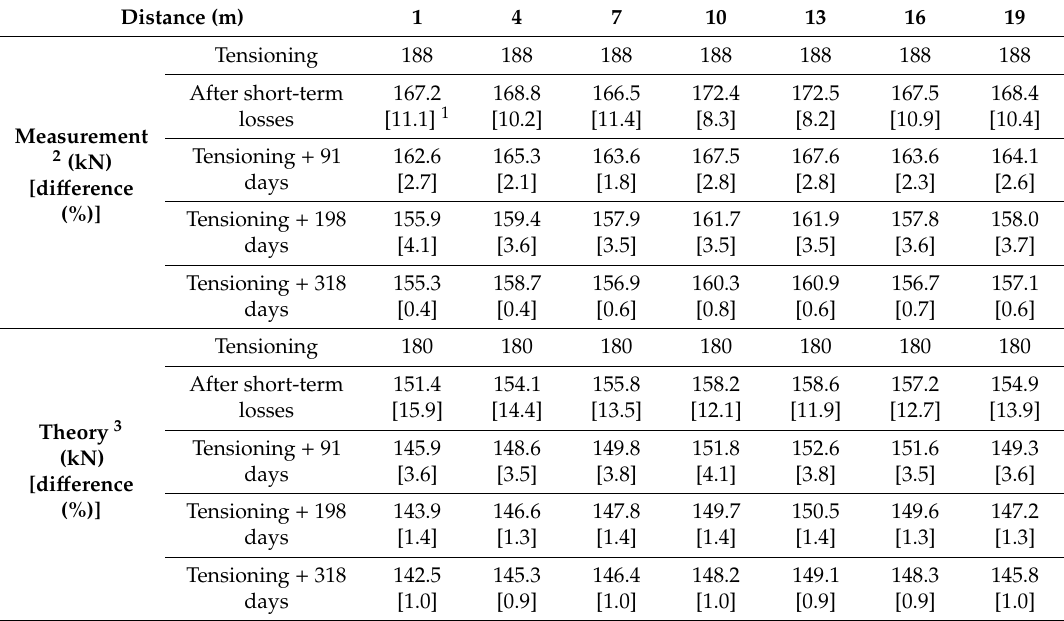
Table 1. PFs at the location of FBGs in the full-scale specimen